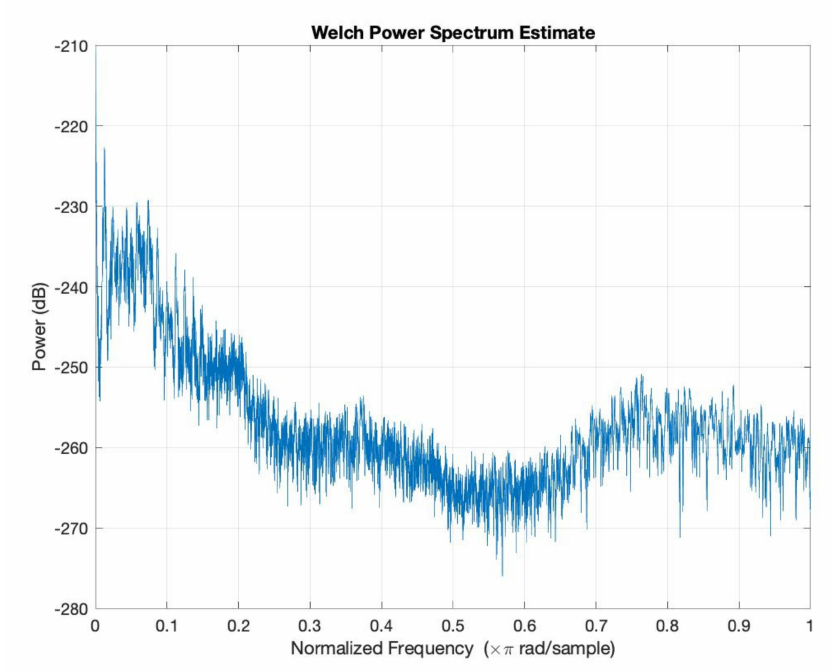
Figure 13. Attenuation of temperature and humidity of the input signal at T = 36 ◦ C and RH =